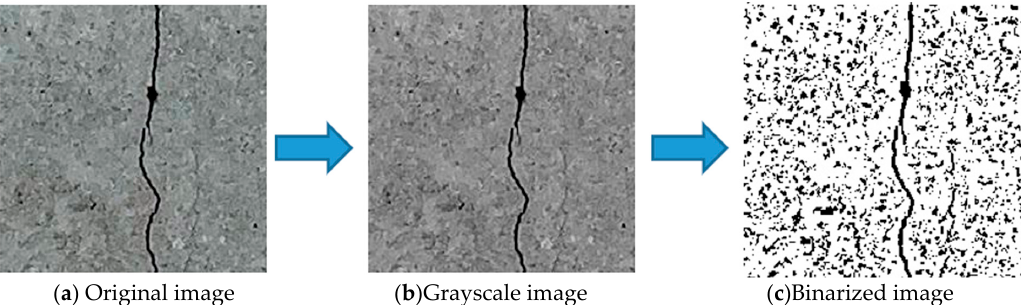
Figure 10. Schematic diagram of the thresholding process.